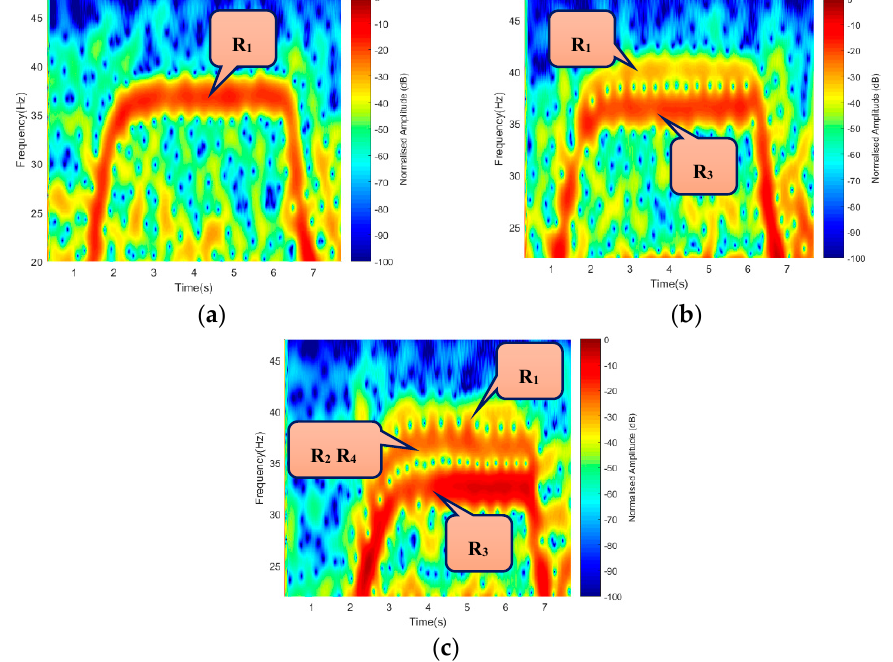
Figure 13. STFT (short-time Fourier transform) representation of ( a ) 1-rotor, ( b ) 2-rotors, and ( c ) 4-rotors.